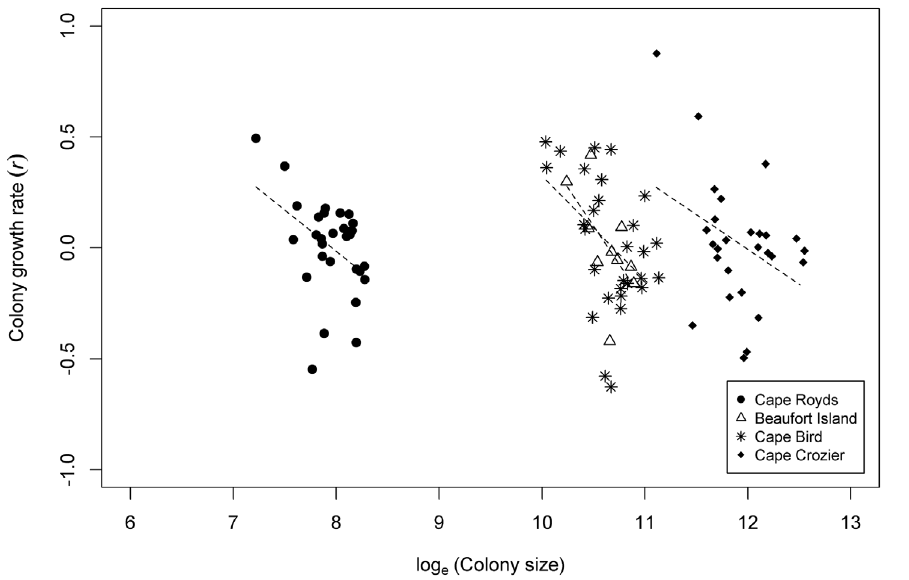
Figure 4. Annual colony growth rate against colony size at Cape Royds, Cape Bird, Cape Crozier and Beaufort Island, Antarctica between 1981 and 2012. A fitted linear trend is indicated by the dashed lines (fitted using ordinary least squares regression).